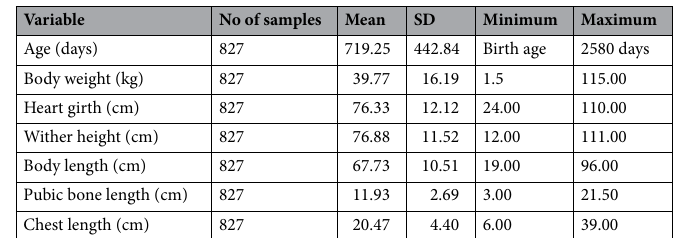
Table 4. Raw Mean, standard deviation, minimum and maximum values for age (months), body weight (kg), heart girth (cm), height (cm), length (cm), pubic bone length (cm) and chest length